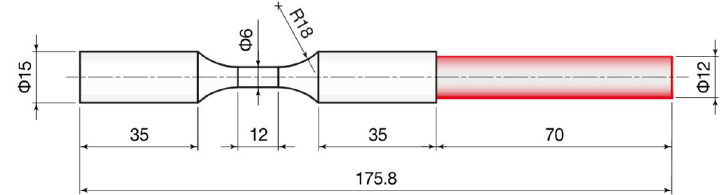
Figure 1. Geometrical features of samples, dimensions in mm.